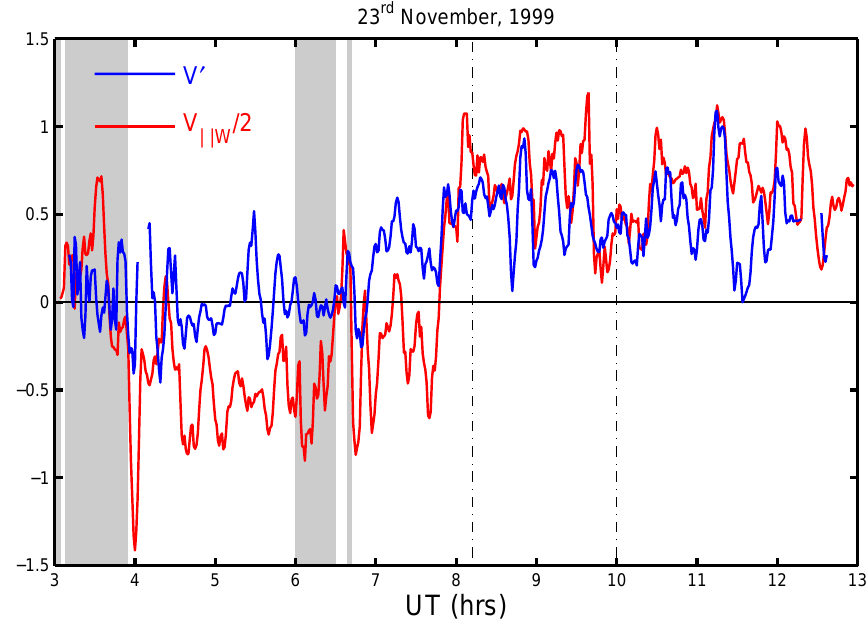
Fig. 13. (Blue) Variations of the boundary-normal convection velocity in the boundary rest frame V 0 = V ⊥ N – V B (positive poleward into the polar cap). (Red) The westward convection velocity V || W derived by combining V 1 and V 2 for the range gates immediately poleward of the open-closed boundary signature. Data are 5-point running means of 1-minute data. As in Fig. 3, areas shaded grey are northward IMF and the vertical dot-dashed lines mark the expansion/recovery phases of the larger